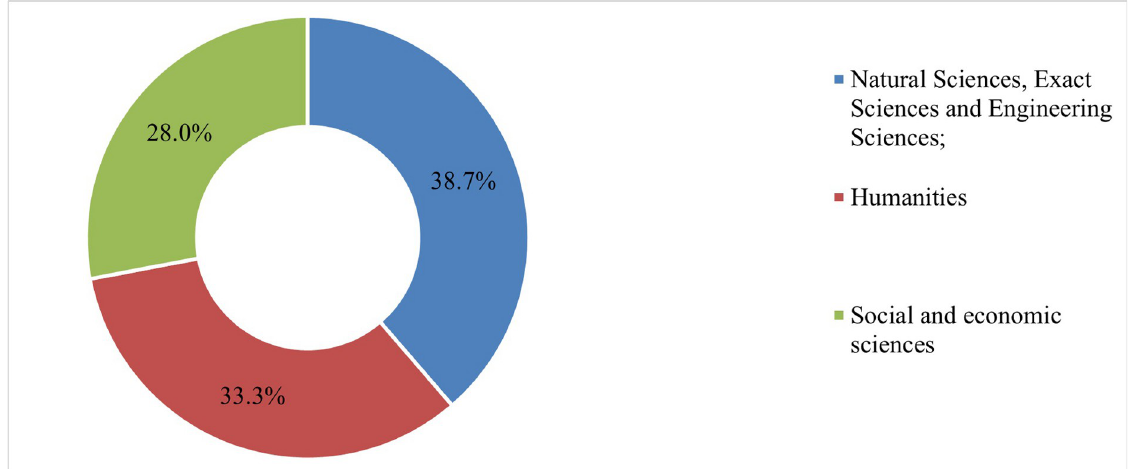
Fig 2. Fundamental areas of interest of the respondents. Source: authors own calculations.